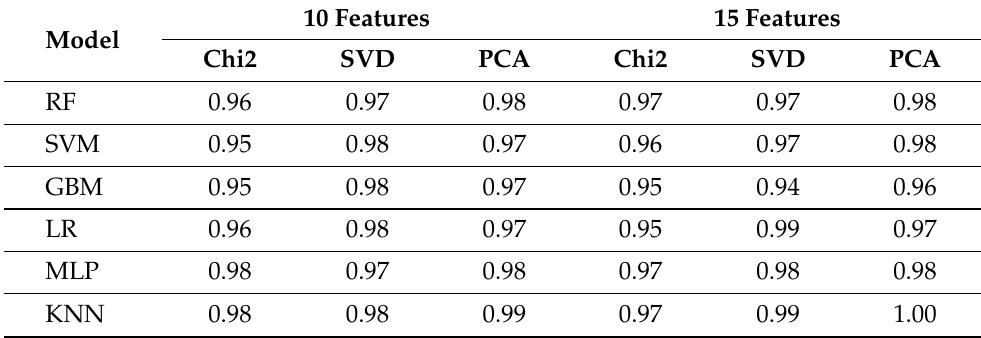
Table 11. Performance of classifiers with 10 and 15 most important features from a balanced dataset. Model